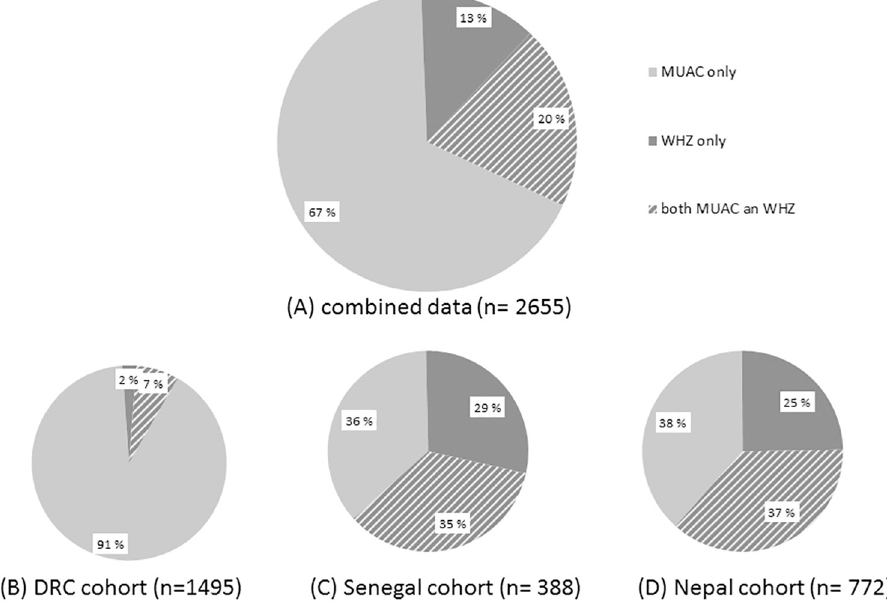
Fig 1. Proportion of children defined as SAM by MUAC-only (solid light grey area), WHZ-only (solid dark grey area) and both MUAC and WHZ (striped area) for (A) the combined data, (B) the DRC cohort, (C) the Senegal cohort, and (D) the Nepal